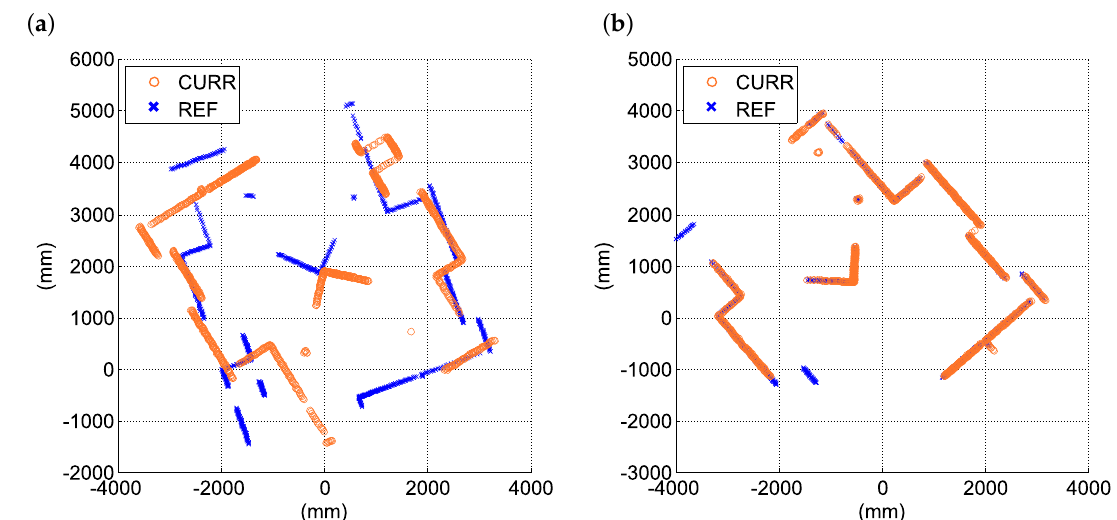
Figure 8. An example of scan alignment by the CORR method: ( a ) Incorrect alignment due to a rotation error. ( b ) Correct alignment.